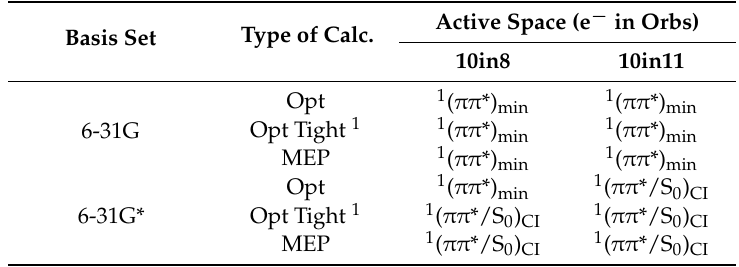
Table 1. Resulting structures for the complete active space self-consistent field (CASSCF) geometry optimizations and minimum energy paths (MEPs) computed on thymine. Basis Set Type of